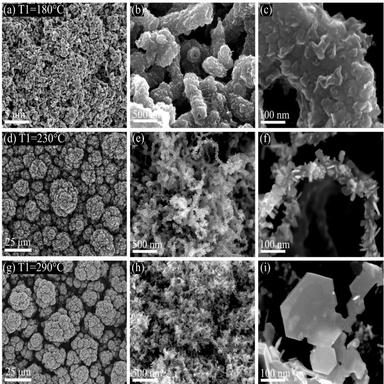
Cristina L. Rodríguez-Corvera et al. SEM images of samples synthesized at T1. (a-c) 180 ◦C, (d-f) 230 ◦C, (g-i) 290 ◦C. Growth of carbon nanofiber surrounded by graphite petal-like structures (a-c), carbon nanotubes decorated by bars and spherical shaped iron-sulfur nanoparticles (d-f), and iron-sulfur hexagonal plateletshaped nanostructures (g-i). In all cases, the furnace-2 (T2) temperature was 850 ◦C, where the samples were grown.